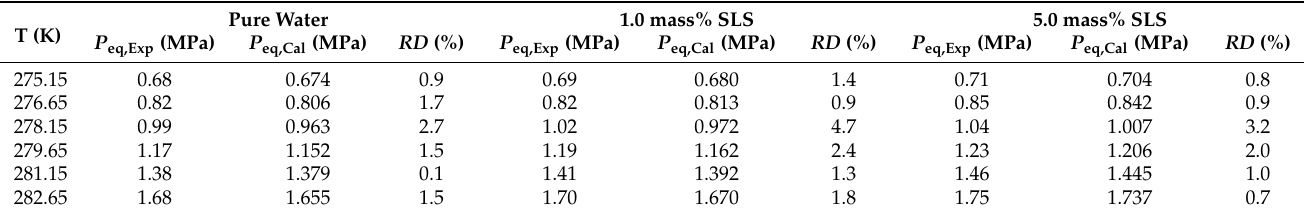
Table 1. The experimental and calculated thermodynamic equilibrium hydrate formation pressures. Pure T (K)